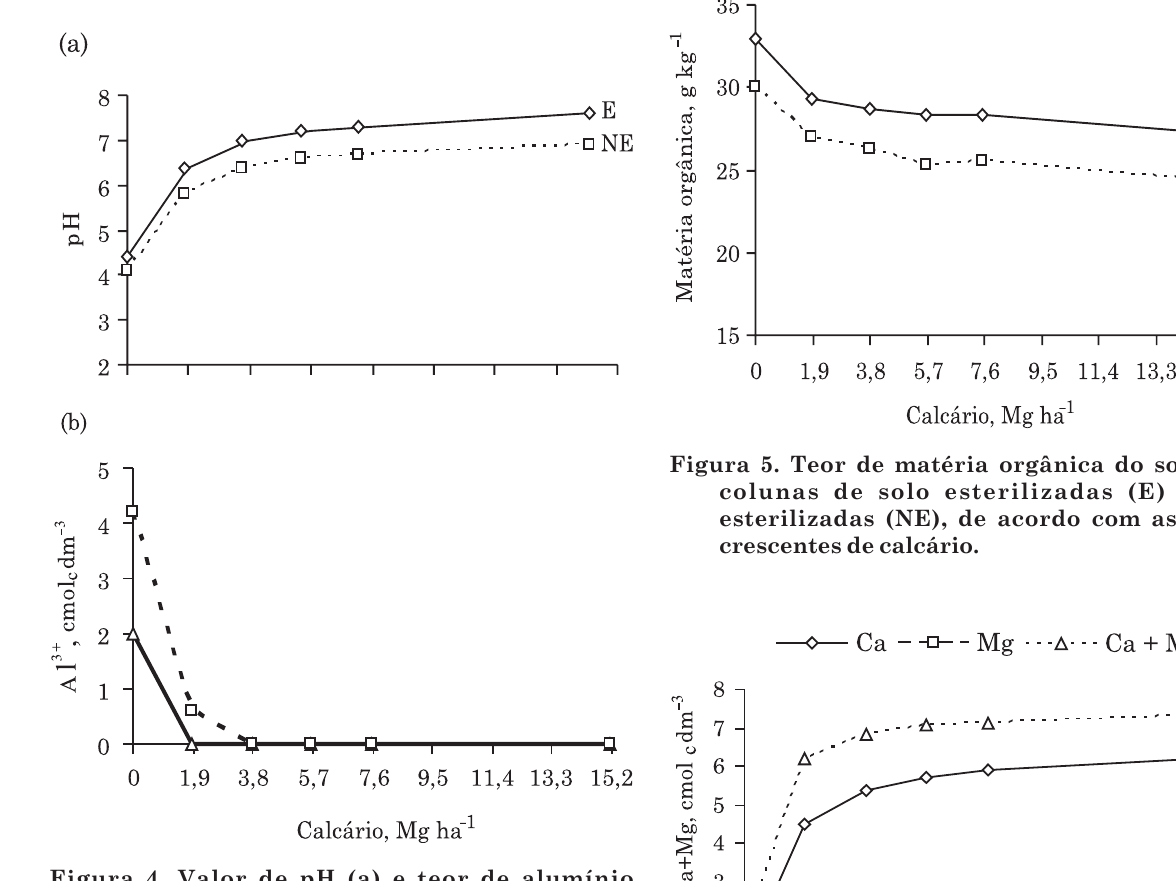
Figura 4. Valor de pH (a) e teor de alumínio trocável (b), em colunas de solo esterilizadas (E) e não esterilizadas (NE), na camada 15 – 20 cm, de acordo com as doses crescentes de calcário.